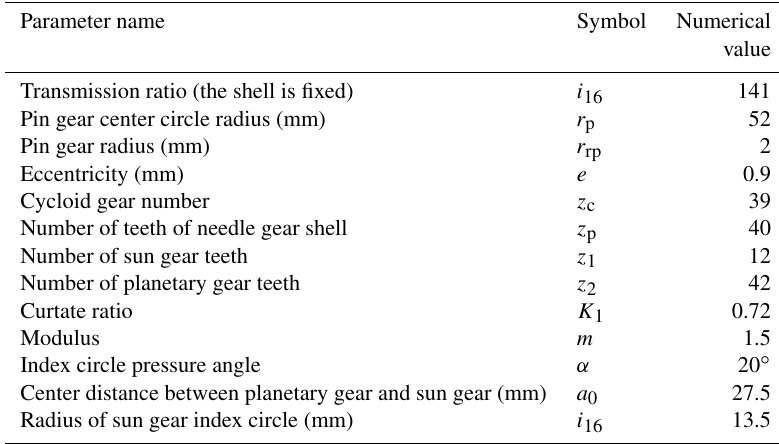
Table 8. Basic parameters of the RV-20E-141 reducer.